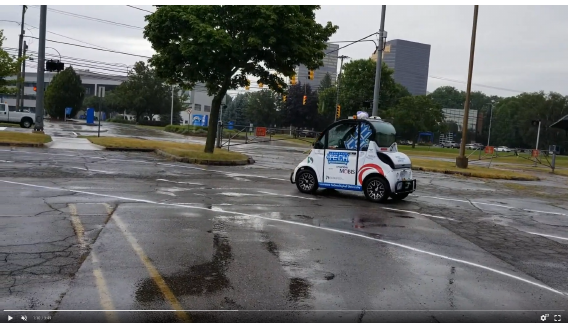
Figure 23. Rainfall leaves reflective puddles across the course making it difficult to detect and track lane lines. Consistent rainfall on the windshield also caused multiple disturbances with camera